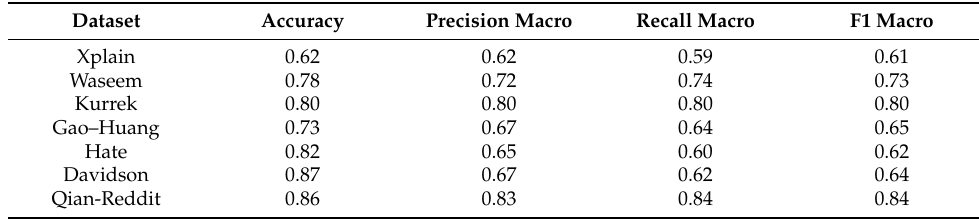
Table A4. Scores obtained on the benchmark Datasets using the random forest algorithm.